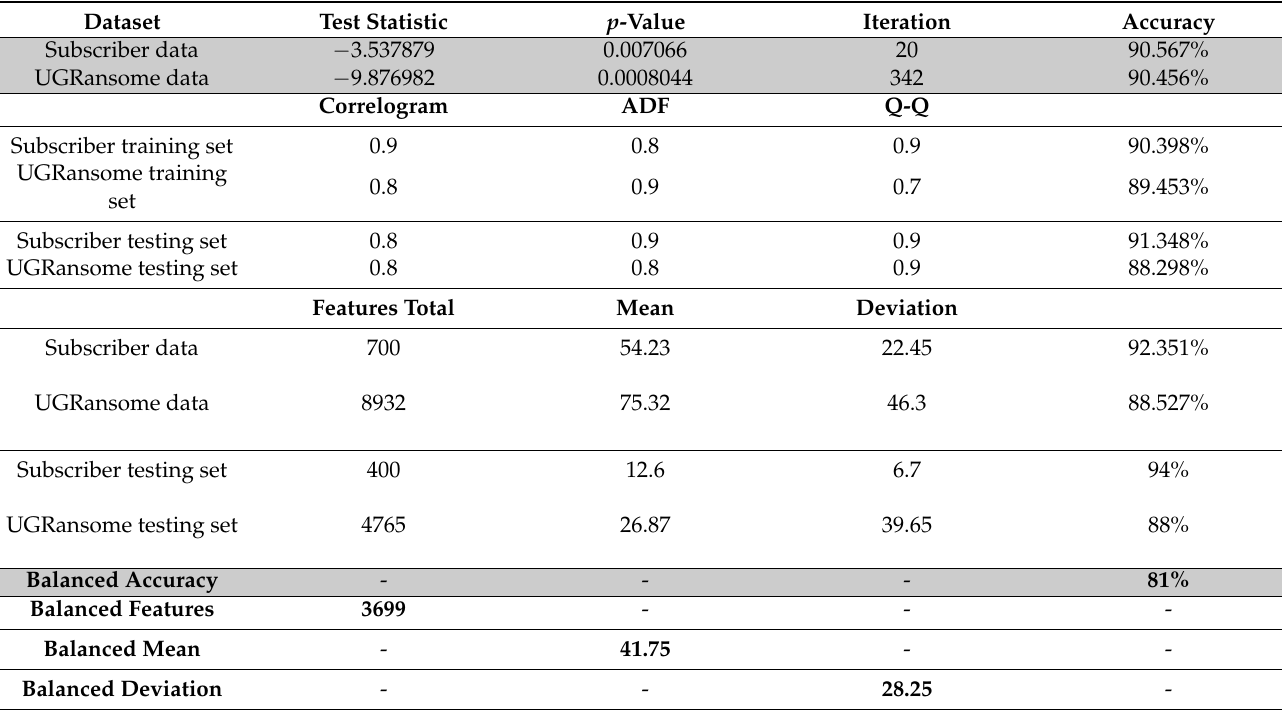
Table 6. The DFT results.